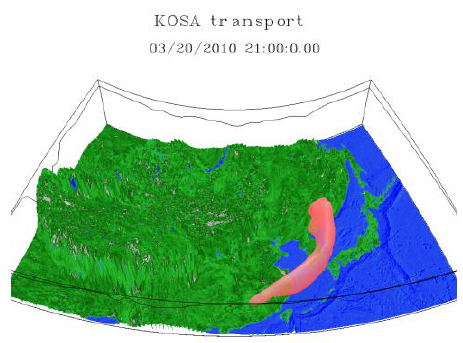
Fig.2 Dust clouds with the concentration larger than 0.6mg/m 3 at 21:00 on March 20, 2010